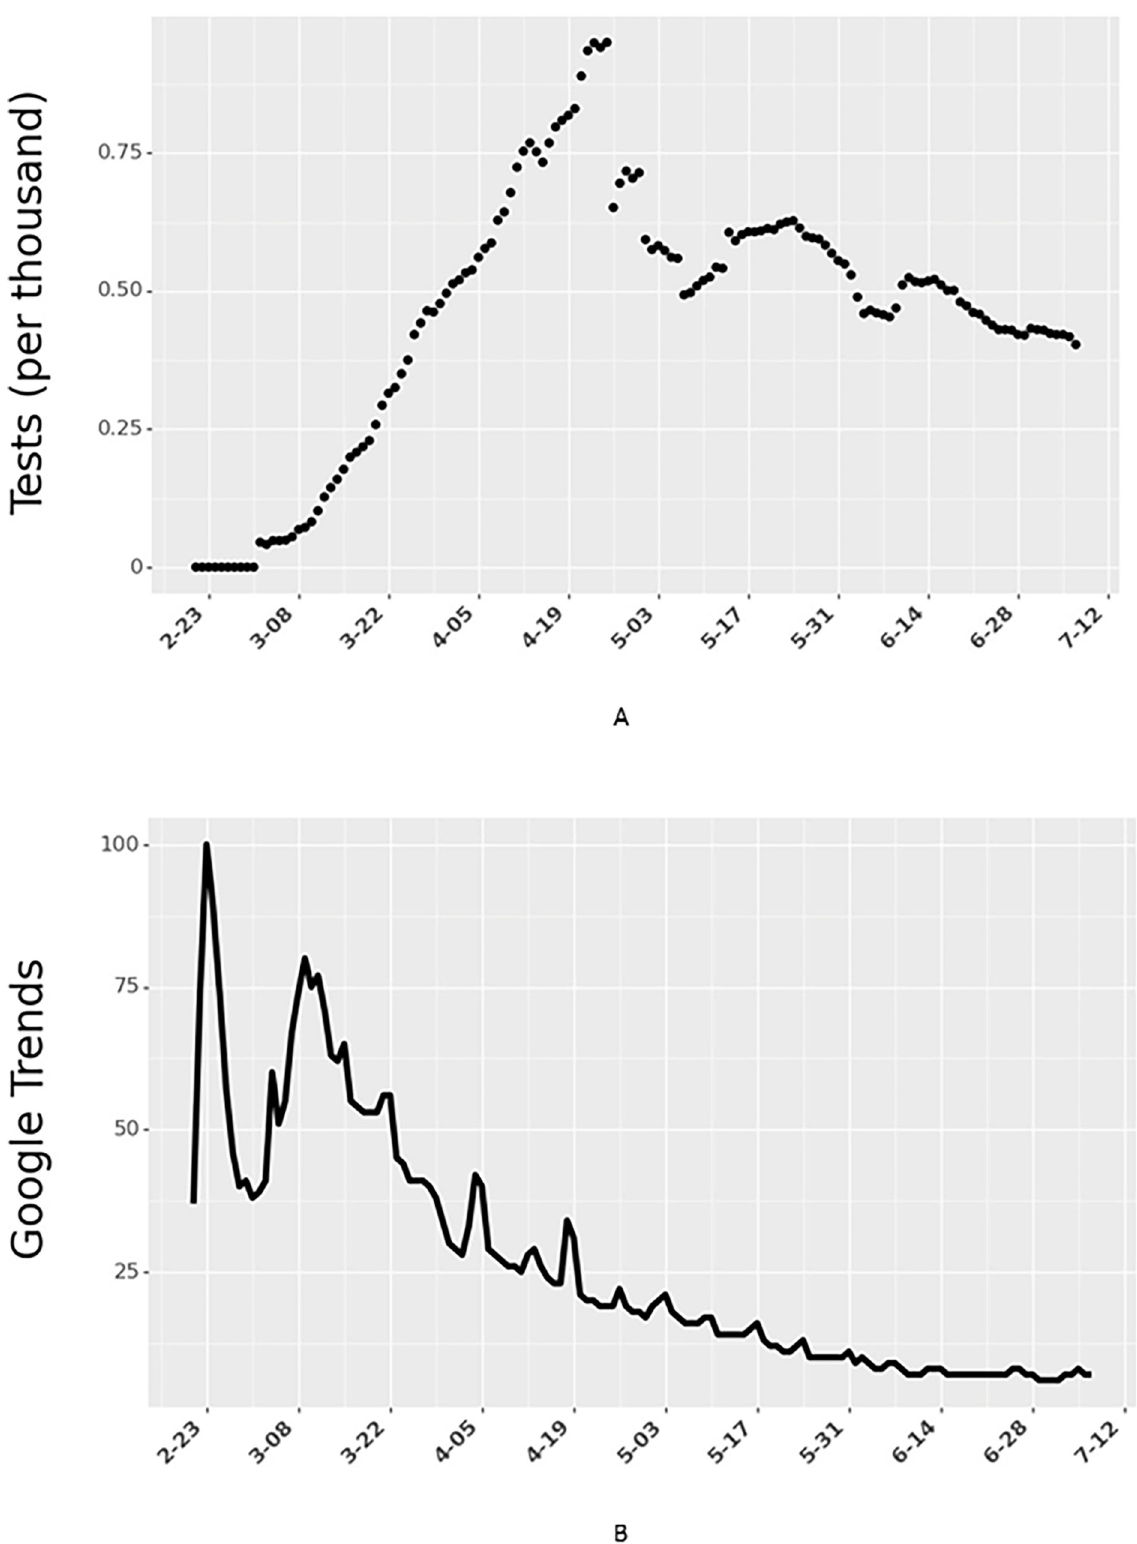
Fig 3. Number of COVID-19 tests (per thousand people) and Google Trends for Italy. Data for all 24 countries is shown in Figs M and N in S1 Text, respectively. https://doi.org/10.1371/journal.pgph.0000954.g003 PLOS Global PublicHealth | https://doi.org/10.1371/journal.pgph.0000954 September 15,